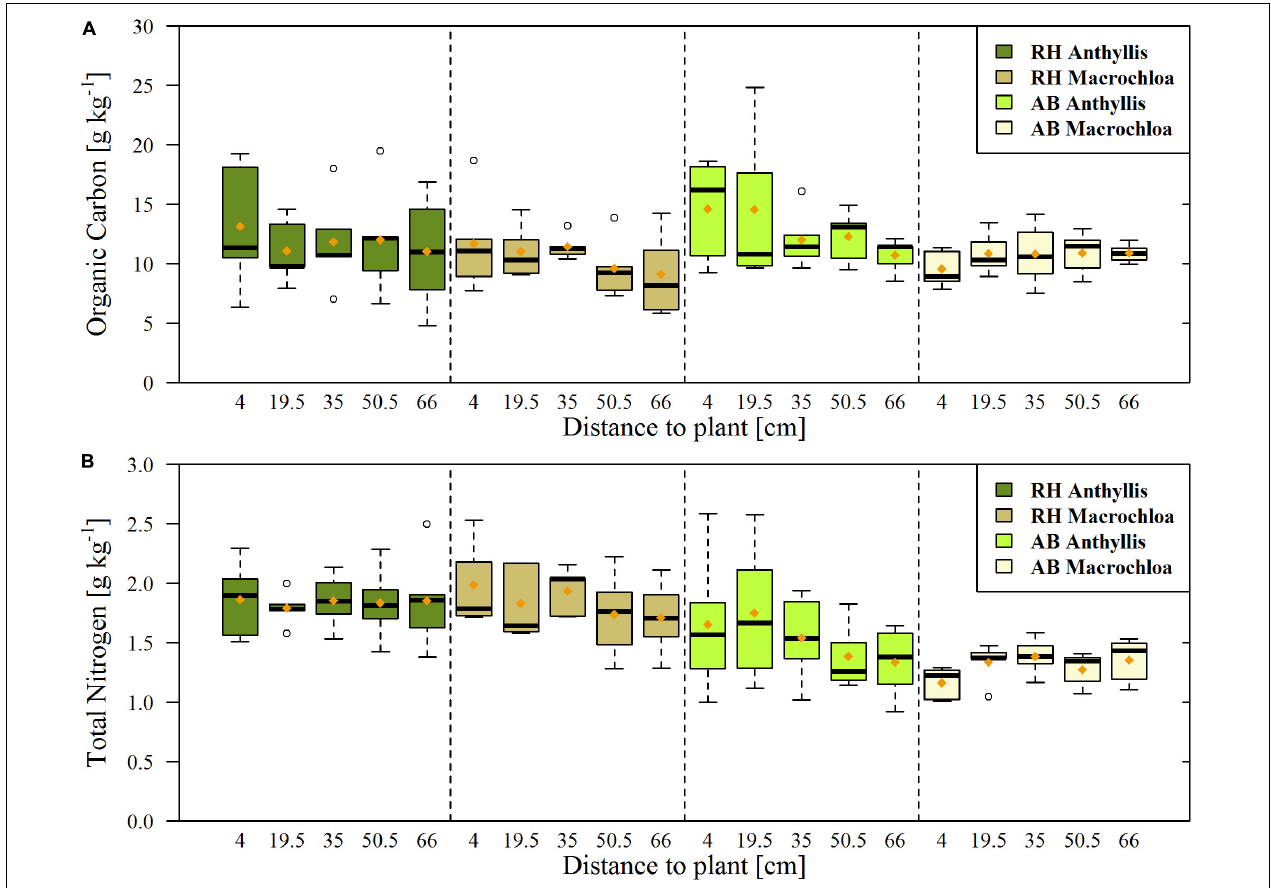
FIGURE 2 | Organic carbon (A) and total nitrogen (B) content of the soil samples from Alboloduy (AB) and Rambla Honda (RH). Box-and-whisker diagrams showing the median (black line), 25th/75th percentile (resp. upper/lower part box), min./max. (whiskers) and mean values (orange dot), with 5 replicates per